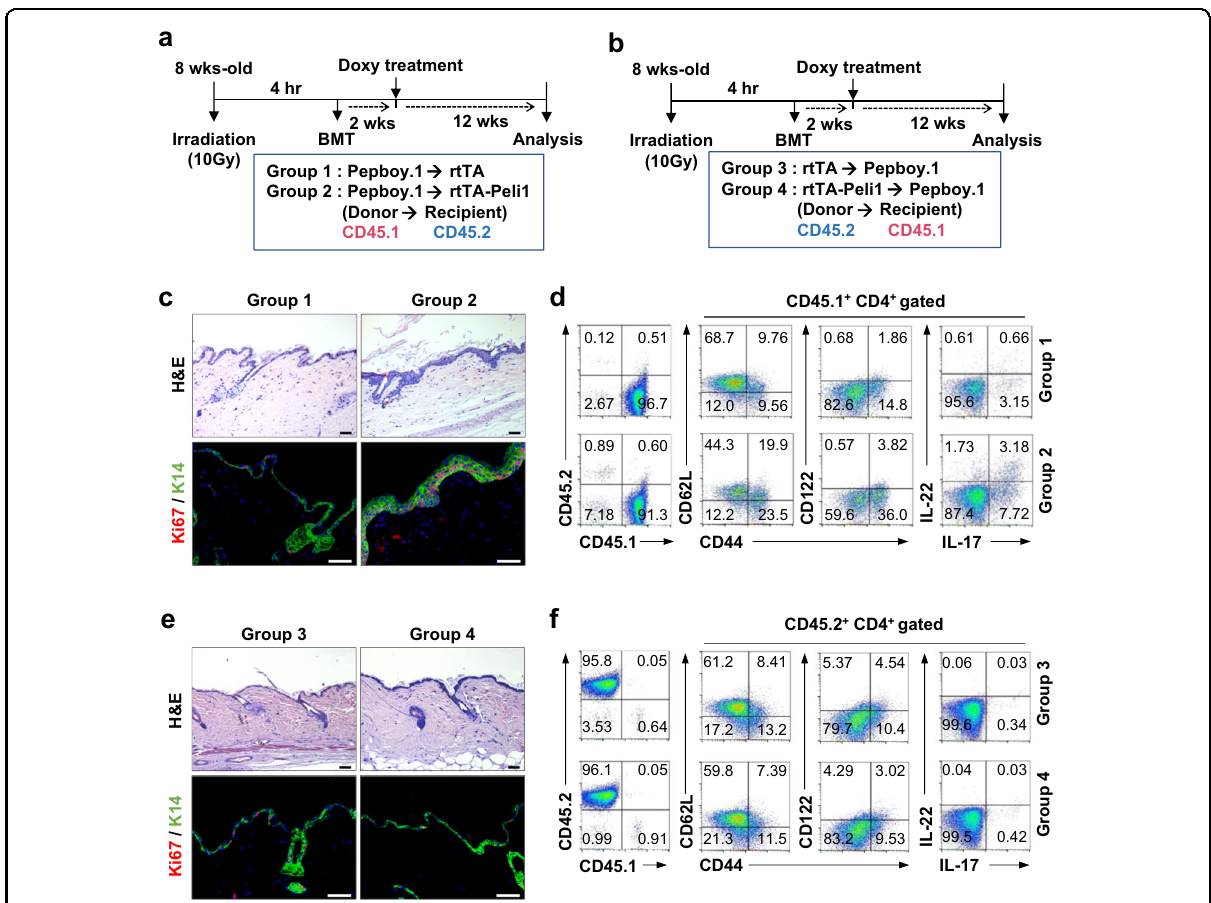
Fig. 3 Overexpression of Peli1 in epidermal cells but not in T cells triggers the development of psoriasis-like disease. a , b Schematic representation of the generation of chimeric recipient mice. Bone marrow (BM) cells were isolated from donor mice and injected into lethally irradiated recipient mice. The following four groups were generated: Pepboy.1 (CD45.1) BM → rtTA (CD45.2) mice (group 1); Pepboy.1 (CD45.1) BM → rtTA-Peli1 (CD45.2) mice (group 2); rtTA (CD45.2) BM → Pepboy.1 (CD45.1) mice (group 3); and rtTA-Peli1 (CD45.2) BM → Pepboy.1 (CD45.1) mice (group 4). After BMT, each group of mice was treated with doxycycline for 12 weeks and then sacri fi ced ( n = 3 for each group). c , e H&E-stained sections of skin from each group of mice treated with doxycycline for 12 weeks. Scale bar, 50 μ m. Immuno fl uorescence of keratin 14 and Ki67 expression. Scale bar, 50 μ m. d , f Representative FACS plots showing the ef fi ciency of bone marrow transplantation, activation of T cells, and intracellular expression of IL-17 and IL-22. Gating blood cells for CD45.1 and CD45.2 expression revealed more than 90% engraftment of donor cells in recipient mice. Lymphocytes were isolated from draining lymph nodes and stained for CD45.1, CD45.2, CD4, CD44, CD62L, CD122, IL-17, and IL-22, followed by fl ow